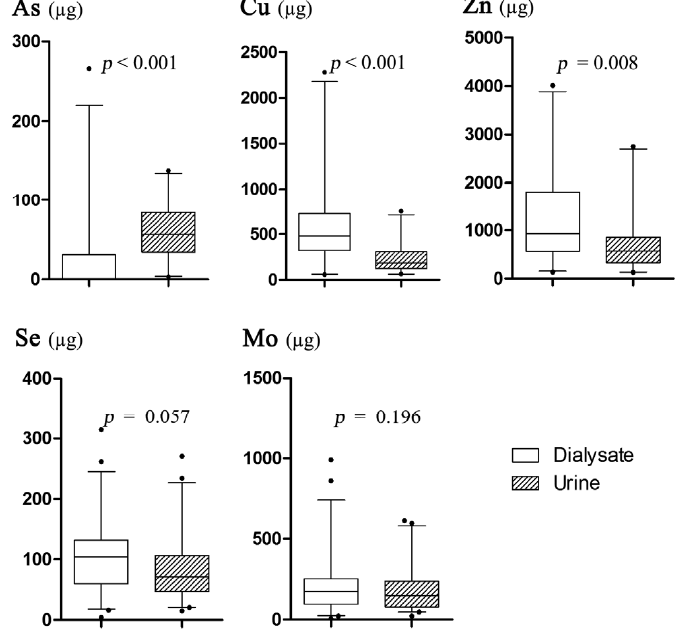
Figure 3. Comparisons of Cu, Zn, Se, Mo, and As excretions per day between dialysate and urine in nonanuric patients.